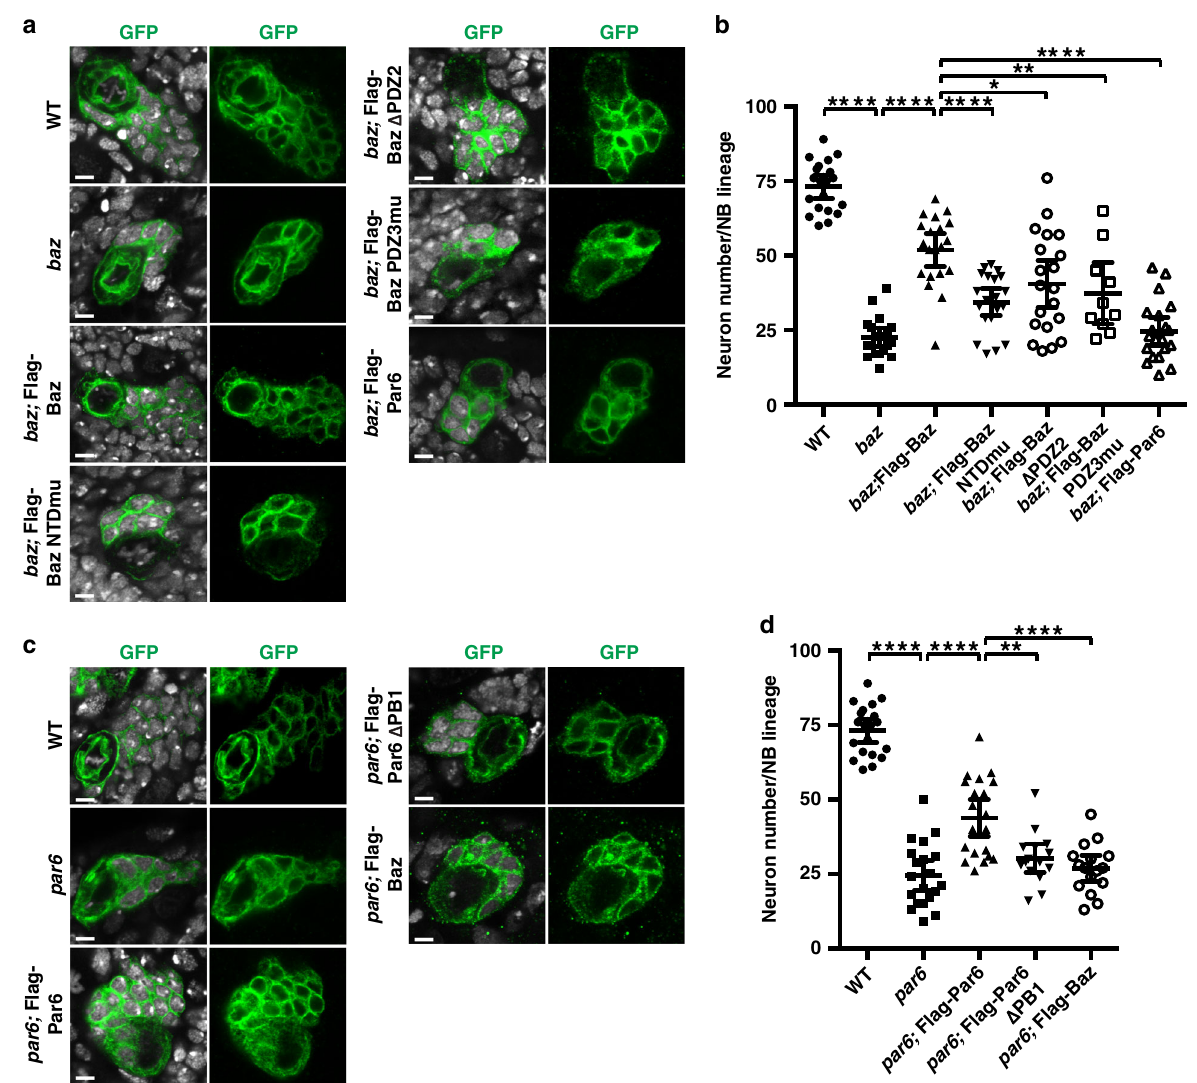
Fig. 8 LLPS of Baz/Par6 is critical for neuronal differentiation in Drosophila NBs. ToPro-3 is in white, GFP in green. Scale bars, 5 µ m. a Representative images showing NB lineage marked by MARCM method for WT, baz mutant clone, or baz mutant clone rescued with WT or different variants. It is noted that the defective lineage development phenotype of baz mutant NBs could be largely rescued with Flag-Baz WT and Flag-Baz Δ PDZ2 , and only partially rescued by the LLPS less ef fi cient Flag-Baz NTDmu and Flag-Baz PDZ3mu , but could not be rescued with Flag-Par6 . b Statistical data for a . For WT, baz , baz ; Flag-Baz, baz ;Flag-Baz NTDmu, baz ;Flag-Baz Δ PDZ2, baz ;Flag-Baz PDZ3mu, and baz ;Flag-Par6, n = 20, 20, 20, 20, 20, 10, and 20 NBs collected from 30 larval brains for each genotype over three independent experiments, respectively. c Representative images showing that par6 mutant NB lineage harboring less progeny that is largely reverted by expression of Flag-Par6 WT but cannot be rescued by the LLPS less ef fi cient Flag-Par6 Δ PB1 variant or Flag-Baz . d Statistical data for c . For WT, par6 , par6 ;Flag-Par6, par6 ;Flag-Par6 Δ PB1, and par6 ;Flag-Baz, n = 20, 20, 20, 15, and 16 NBs collected from 30 larval brains for each genotype over three independent experiments, respectively. For all the statistical data, mean ± 95% con fi dence interval is shown. ns, not signi fi cant; * p < 0.05, ** p < 0.01, *** p < 0.001, and **** p < 0.0001 using one-way ANOVA with Tukey ’ s multiple comparison test. All the constructs are listed in Supplementary Table 1. Source data are provided as a Source data fi